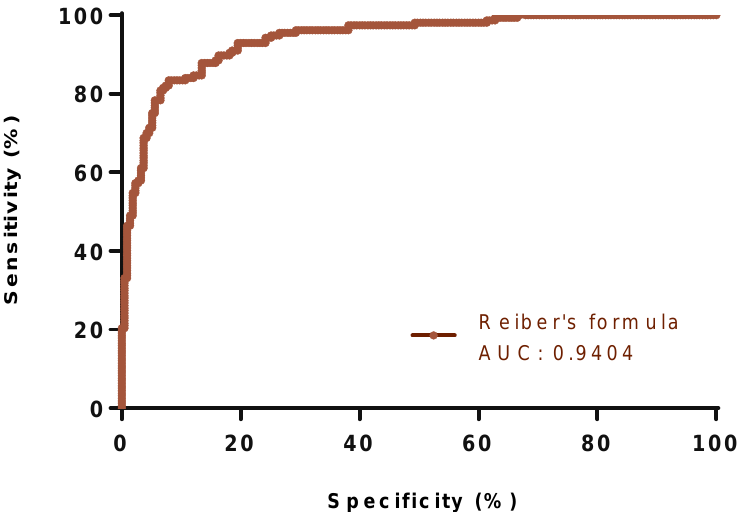
Figure 2. The ROC curve of Reiber’s formula for discriminating between OCB-positive (n = 157) and negative (n = 215) patients. Abbreviations: AUC, area under the curve.